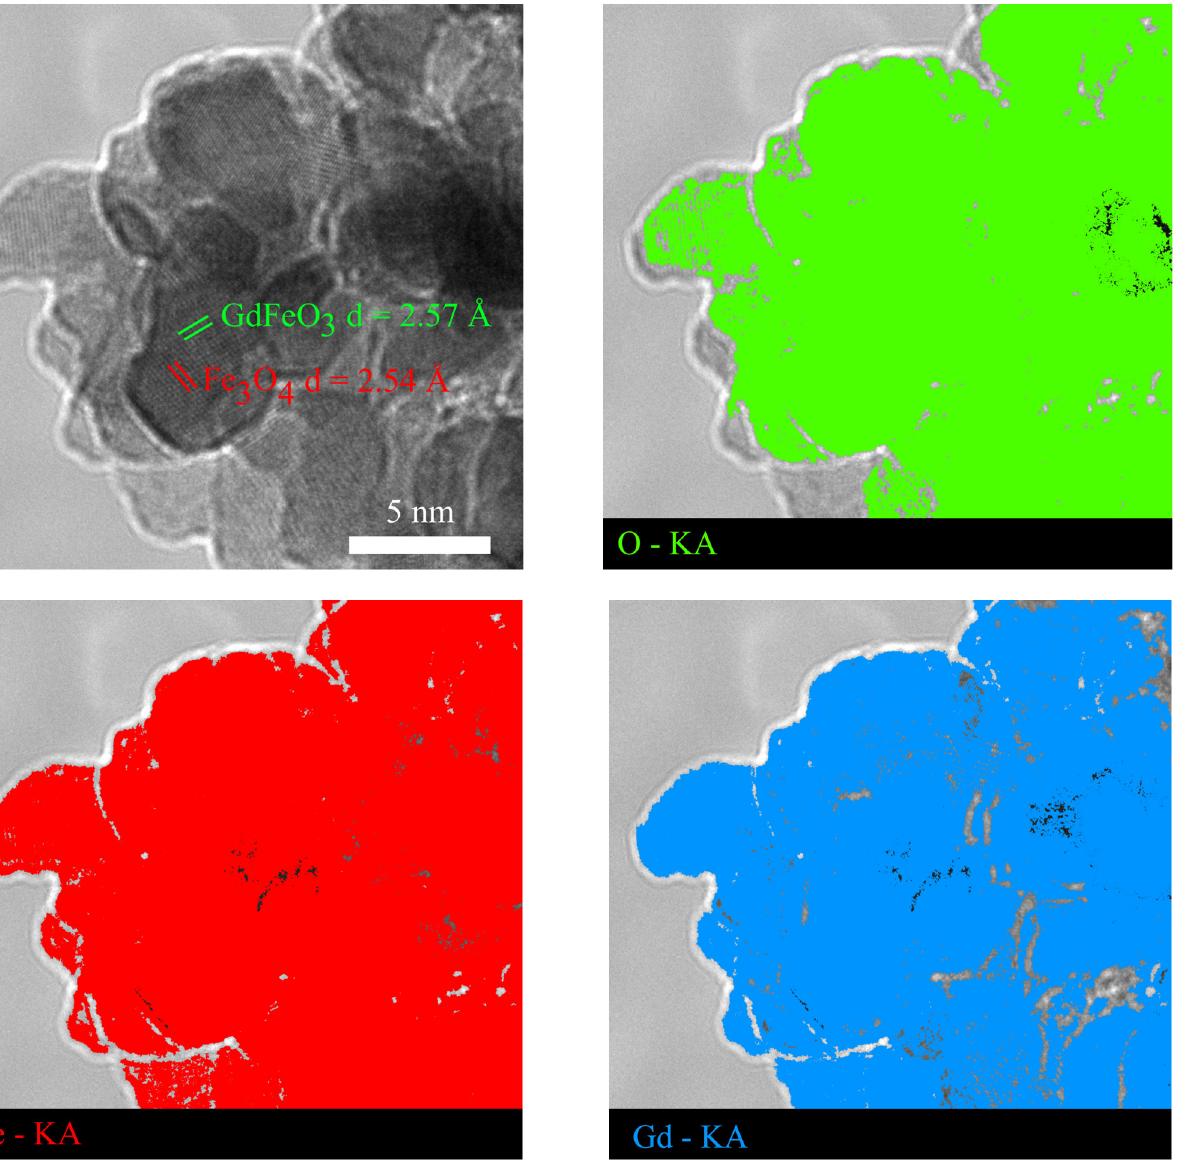
Figure 3. TEM data and energy dispersive analysis of the studied S3 samples.